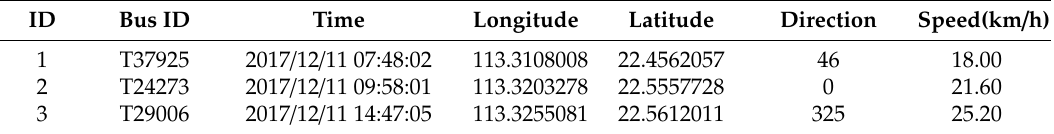
Table 3. Bus trajectory data examples.